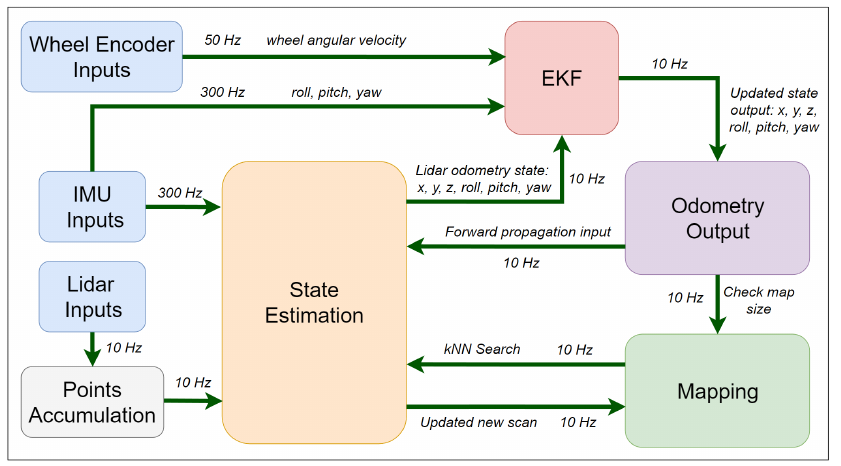
Figure 3. Overview of the modified FAST-LIO2 SLAM